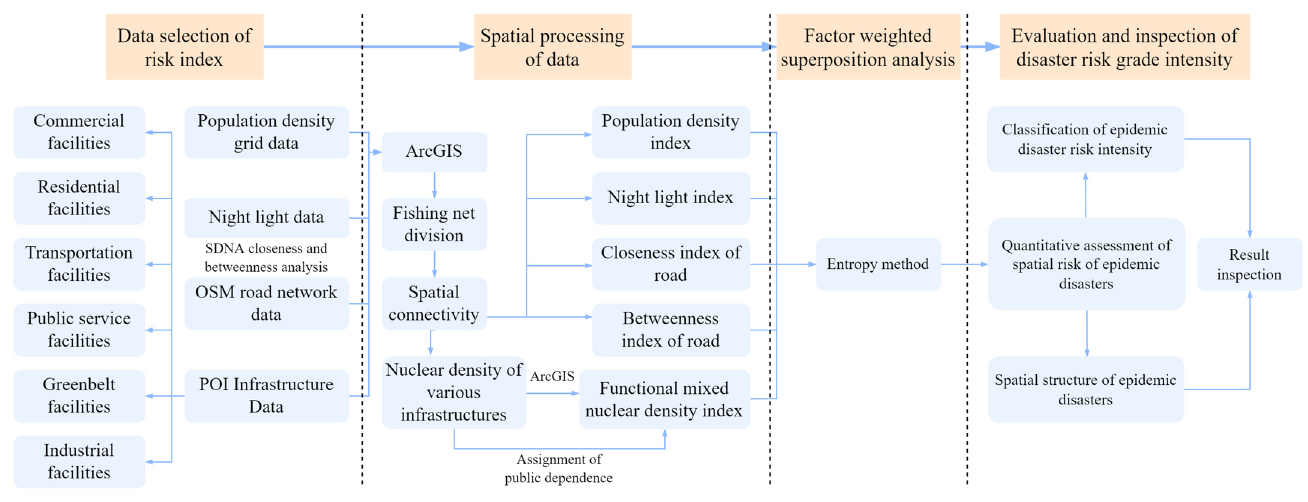
Figure 4. Research technology route. Table 1. Disaster Risk